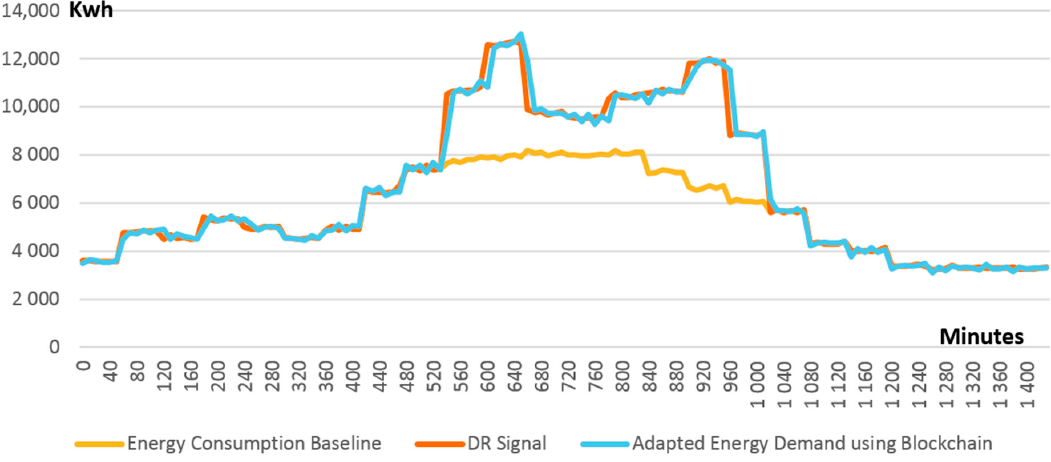
Figure 11. Actual versus expected energy demand using blockchain based control.